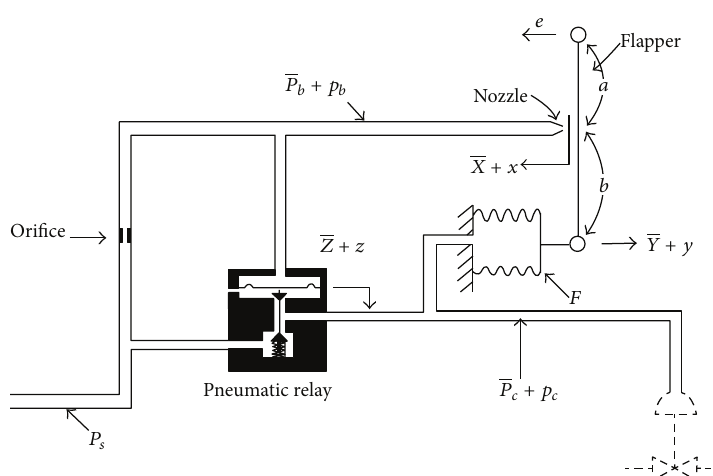
Figure 1: Schematic diagram of a force-distance type of pneumatic proportional controller.